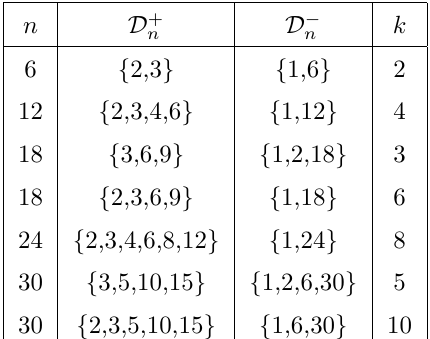
( y ) from (3.16). The third n